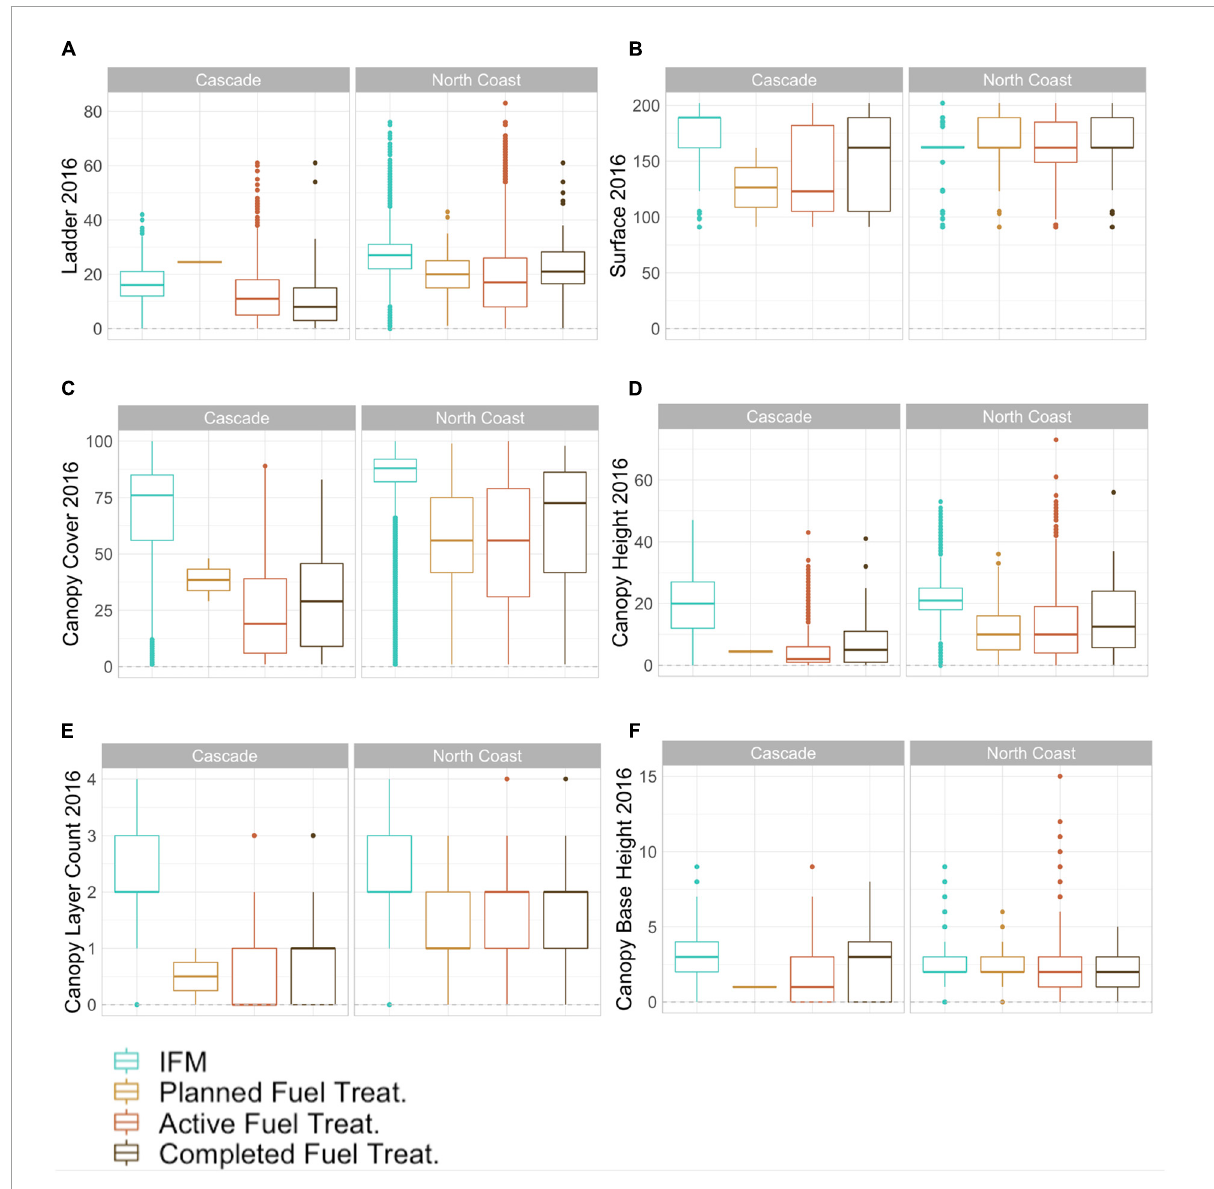
FIGURE2 Boxplots of the 2016 fuel estimates for the IFM projects and fuel treatments (planned, active, and completed) across the Southern Cascade and North Coast regions.